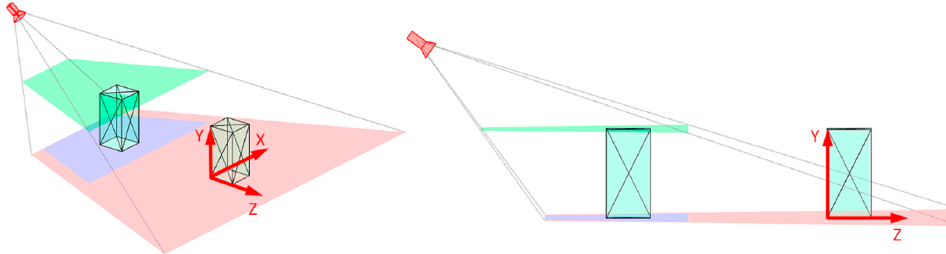
Figure 4. The view area upper bound height.